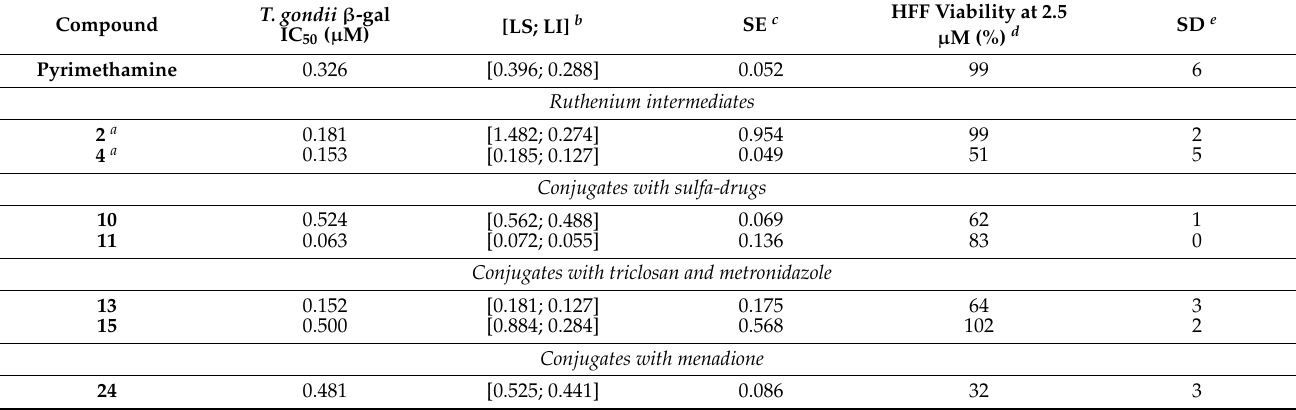
Table 5. Half-maximal inhibitory concentration (IC 50 ) values ( µ M) on T. gondii β -gal for seven selected compounds and pyrimethamine (used as standard), and their effect at 2.5 µ M on HFF viability.